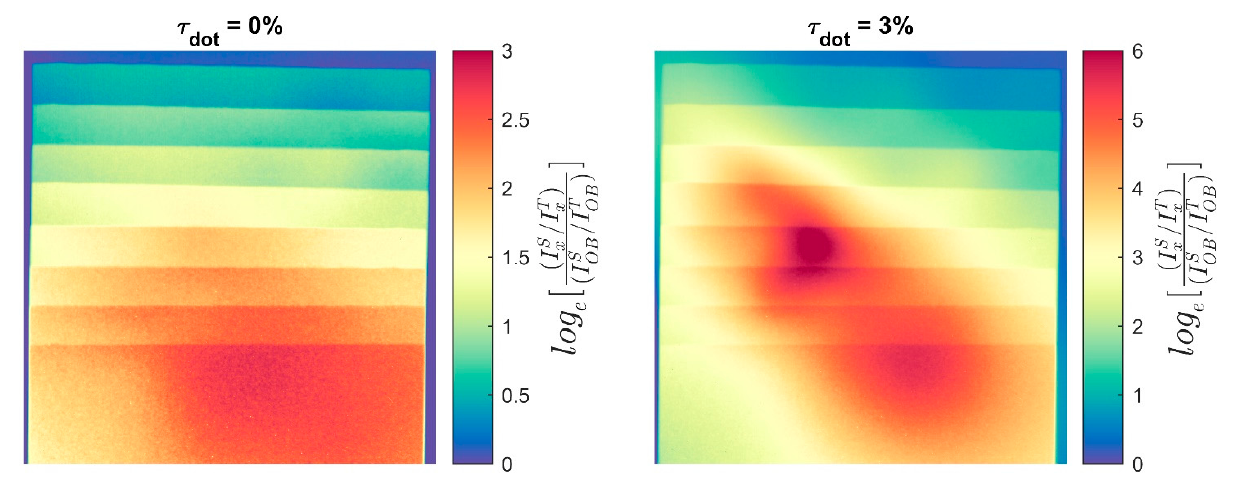
Figure 15. Log-normalized scattering-to-transmission ratios for PMMA step wedge at CG-1D.